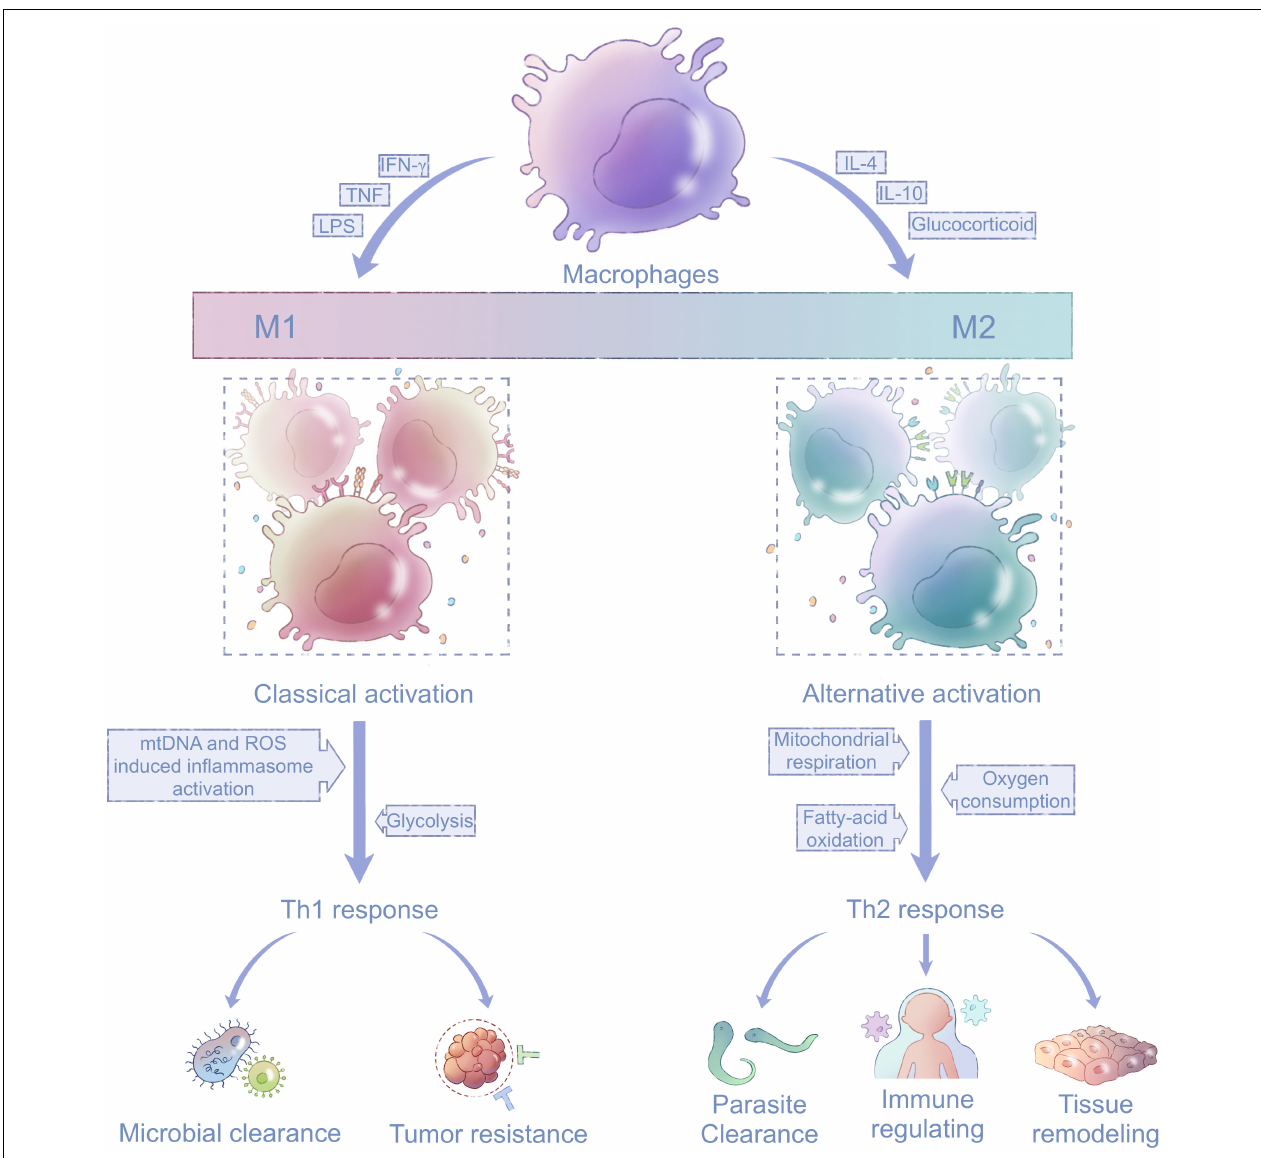
FIGURE 2 | Mitochondria in macrophage polarization. Macrophages are activated and polarized in response to different stimuli, including TNF, IFN- γ , LPS, IL-4, IL-10, and glucocorticoids. The states of macrophages fall between two extremes, M1 and M2 phenotypes, which participate in the Th1 and Th2 immune responses, respectively. Energy metabolism in M1-polarized macrophages shifts to glycolysis compared with their precursors, and M1-polarized macrophages are activated by mtDNA and mitochondria-produced ROS (left). Energy metabolism in M2-polarized macrophages mainly depends on mitochondrial respiration fueled by oxygen and fatty acids (right). TNF, tumor necrosis factor; IFN- γ , interferon- γ ; LPS, lipopolysaccharide; IL-4, interleukin-4; IL-10, interleukin-10; ROS, reactive oxidative species; and mtDNA, mitochondrial